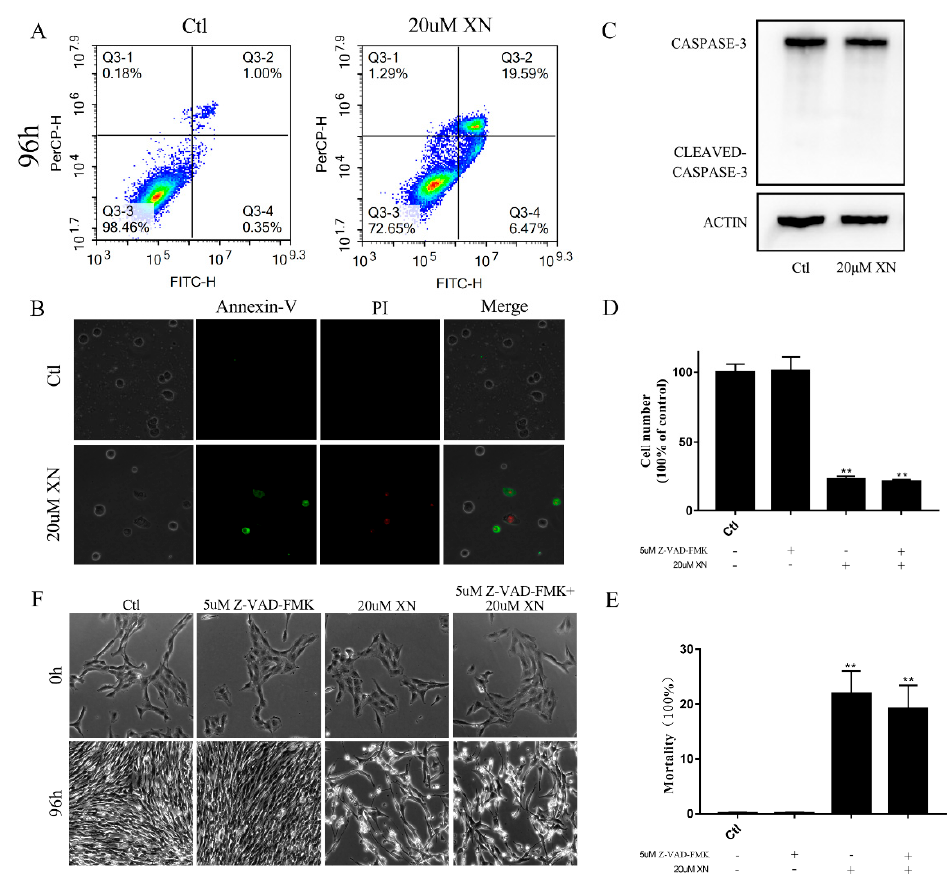
Figure 2. XN-induced apoptosis of C6 cells. ( A , B ) C6 cell apoptosis evaluation by flow cytometry and fluorescence microscopy through Annexin-V/PI double staining after treatment with XN for 96 h (400 × g magnification). ( C ) Cleaved caspase-3 was detected by Western blot (WB) after XN incubation for 96 h. ( D – F ) The C6 cells were pretreated with 5 uM inhibitor of caspase-3 Z-VAD-FMK for 1.5 h before the co-treatment with XN for another 96 h. The morphology changes were captured by a Leica Microsystems microscope (200 × g magnification), and cell viability and cell death were measured by trypan blue staining. All data presented are the mean ± SEM from three independent experiments. ** p < 0.01 vs. control.